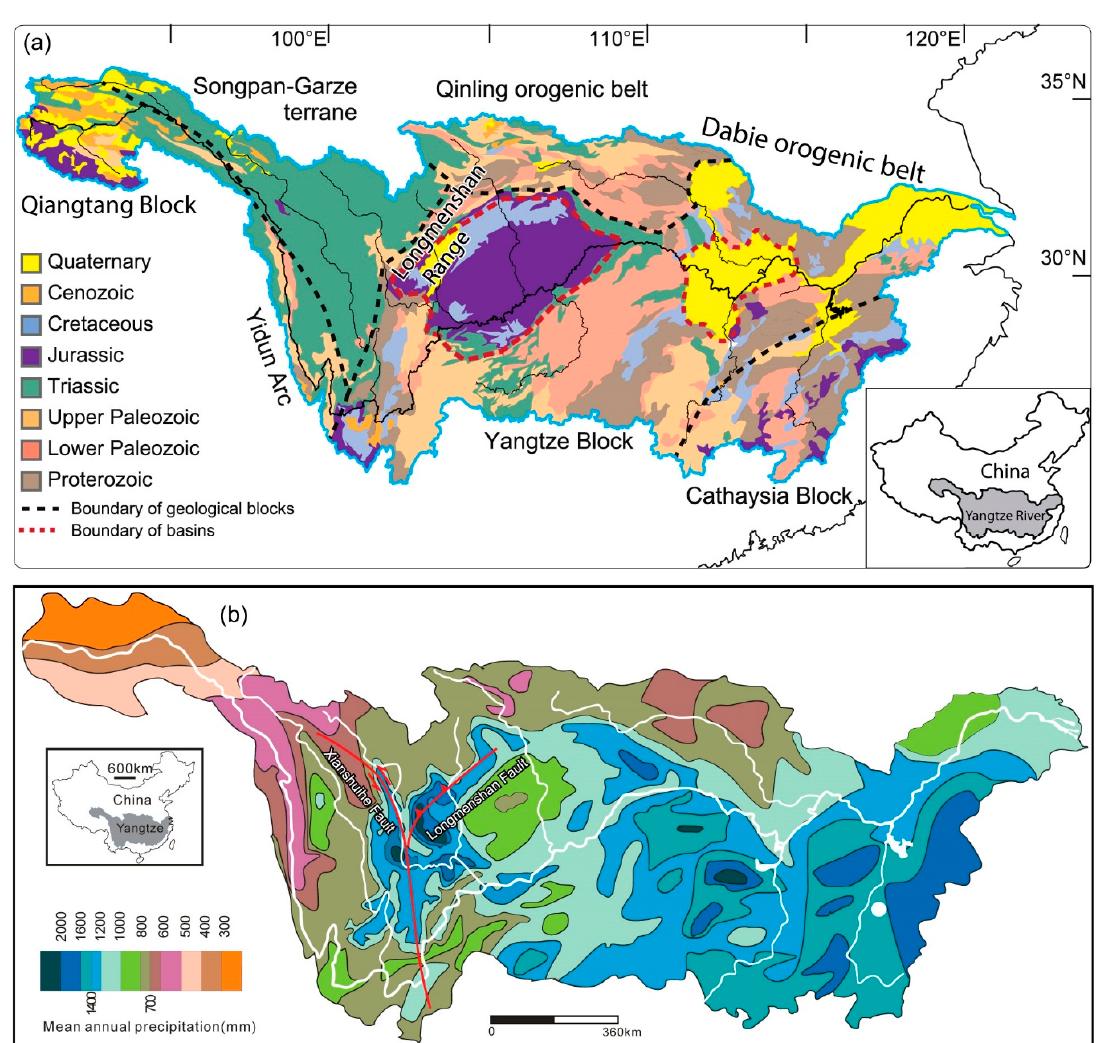
Figure 2. Generalized geological map ( a ) (Modified from Saito et al. [28]) and the mean annual precipitation distribution of the Yangtze River ( b ). The mean annual precipitation distribution map modified from Sun et al. [24].